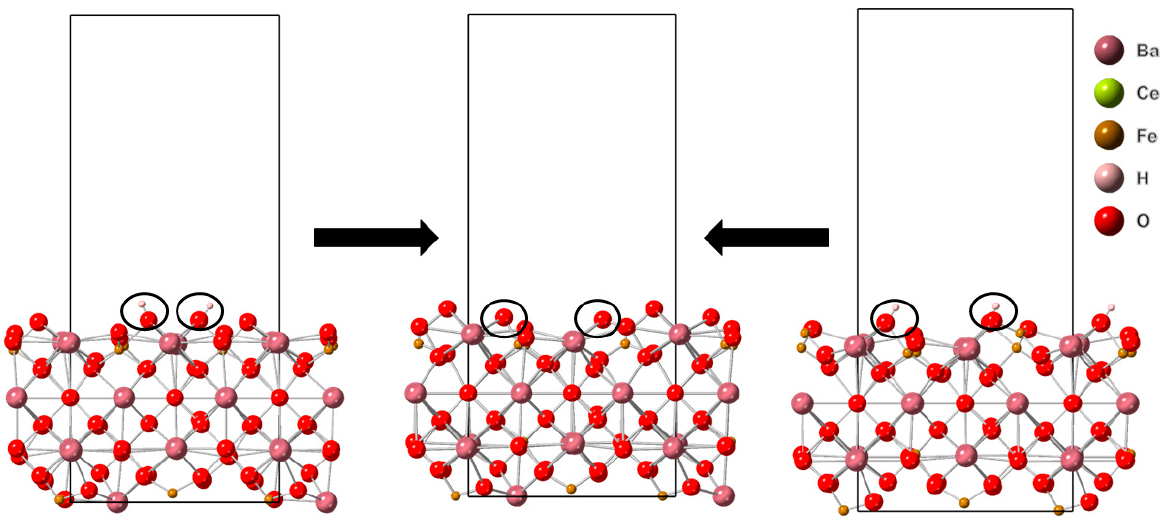
Figure 8. The reaction sites are indicated by white circles. Lefthand structure stoichiometry is Ba 16 Ce 14 Fe 2 H 2 O 47 . The righthand structure stoichiometry is Ba 16 Ce 2 Fe 14 H 2 O 46 . The center structure stoichiometry is Ba 16 Ce 2 Fe 14 O 46 . Images generated using CrystalMaker ® , CrystalMaker Software Ltd., (Oxford, UK), (www.crystalmaker.com, accessed on 26 December 2022).